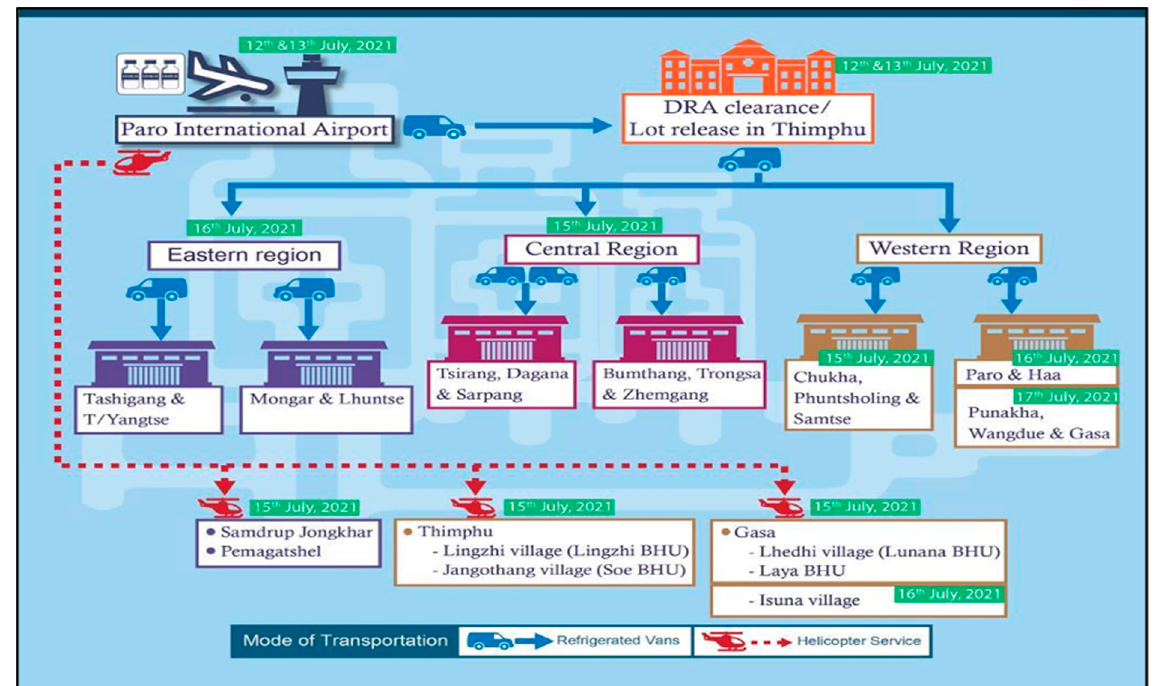
Figure 1. Algorithm for vaccination process.